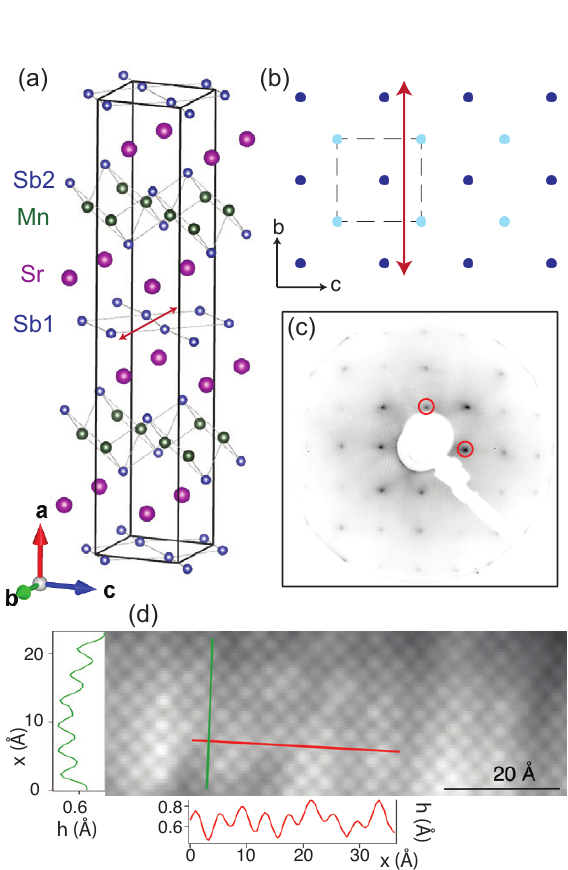
Figure 1: Bulk and surface crystallographic structure. (a): Crystal structure of SrMnSb featuring two inequivalent Sb positions, labelled as Sb1 and Sb2. The Sb1 plane is sandwiched between two staggered Sr planes. The Sb2 atoms sandwich a plane of the Mn atoms. (b): A plan view of the Sb1 plane, the key structural element of the crystal. The buckling of the Sb1 plane out of the b - c plane is indicated using different shades for the Sb1 atoms. A non- symmorphic symmetry element in the form of a screw axis is indicated as a red arrow aligned along b . (c): LEED diffraction pattern of an in-situ cleave of SrMnSb incident electron energy of 220 eV at 30 K. The pattern is of a (1 × 1) type, whereby the red circles highlight the (1,0) and (0,1) (h,k) diffraction spots. (d) STM topograph of cleaved SrMnSb measured at 77 K in UHV using a Pt / Ir tip at V = -600 mV and I = 95.8 pA. The 2 same (1 × 1) surface symmetry is seen as in the LEED data, and the interatomic separation corresponds to the net of the Sb1